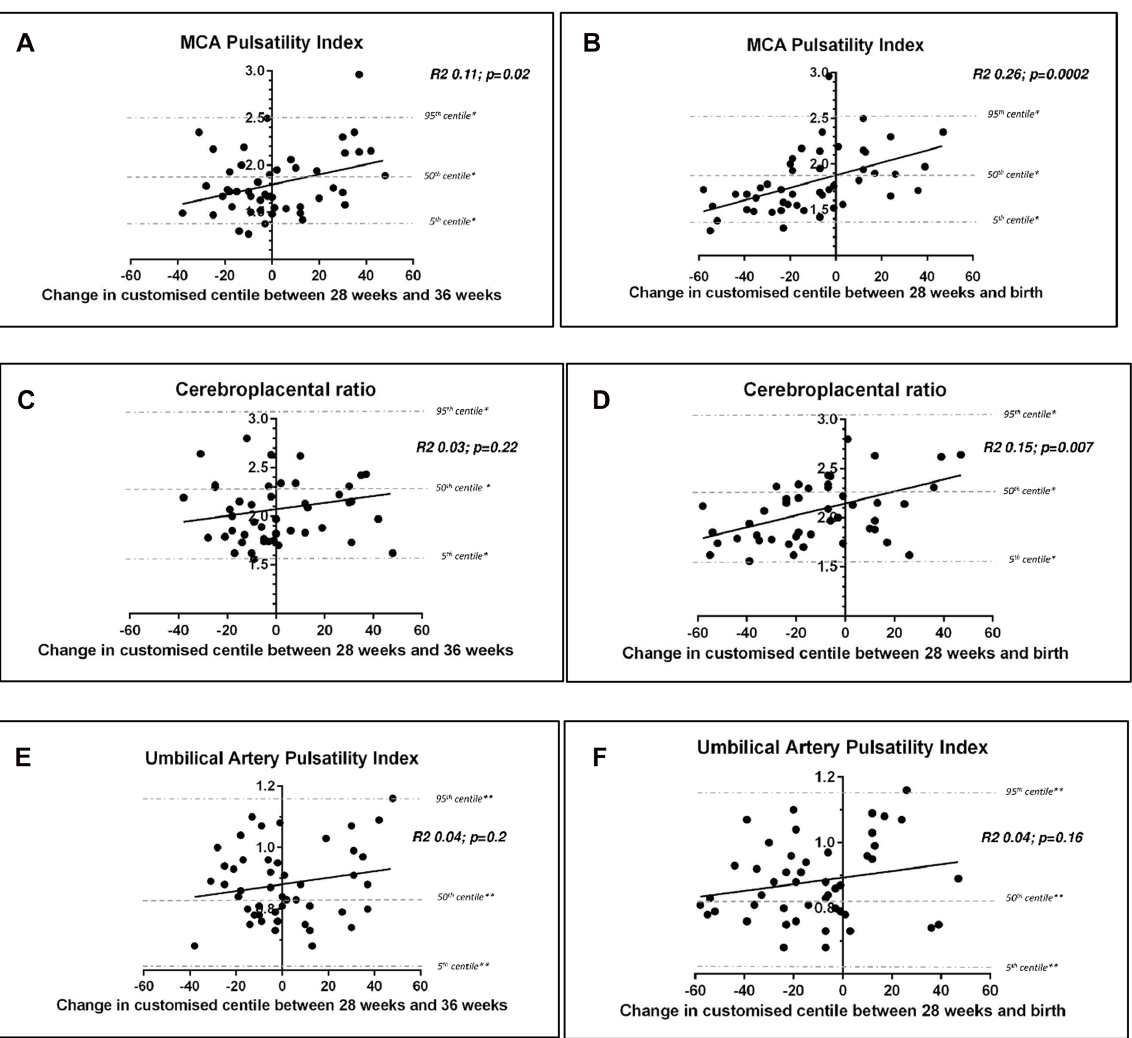
Fig 2. Doppler assessments performed at 36 weeks according to change in weight centile. MCA-PI according to weight centile change between the ultrasound performed at 28 weeks and 36 weeks (2a) MCA-PI according to weight centile change between the ultrasound performed at 28 weeks and birth (2b). CPR according to weight centile change between the ultrasound performed at 28 weeks and 36 weeks (2c) CPR according to weight centile change between the ultrasound performed at 28 weeks and birth (2d); UA-PI according to weight centile change between the ultrasound performed at 28 weeks and 36 weeks (2e) UA-PI according to weight centile change between the ultrasound performed at 28 weeks and birth (2f). * 5 th , 50 th and 95 th centile for Middle Cerebral Artery Pulsatility Index and Cerebroplacental Ratio at 36 weeks gestation (12); ** 5 th , 50 th and 95 th centile for Umbilical Artery Pulsatility Index at 36 weeks gestation